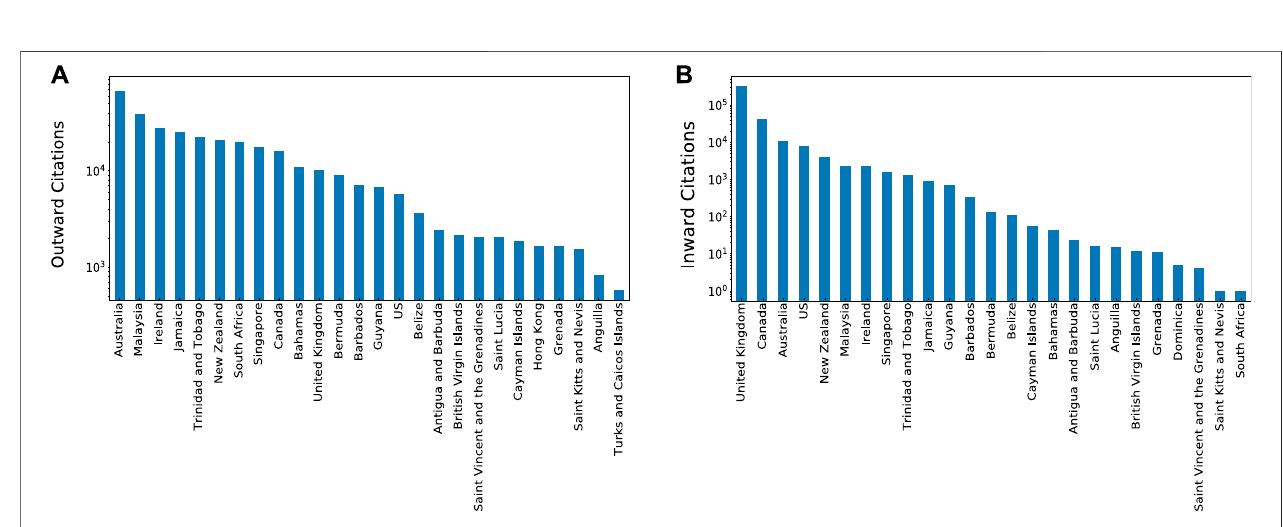
FIGURE 7 | Connected components. (A) Connected components on for a graph G (cid:1) { V , E } at time t illustrating the largest connected component (LCC). (B) Temporal connected components with fi ve window widths showing the change in the proportion of the LLC in the cross-jurisdictional network.